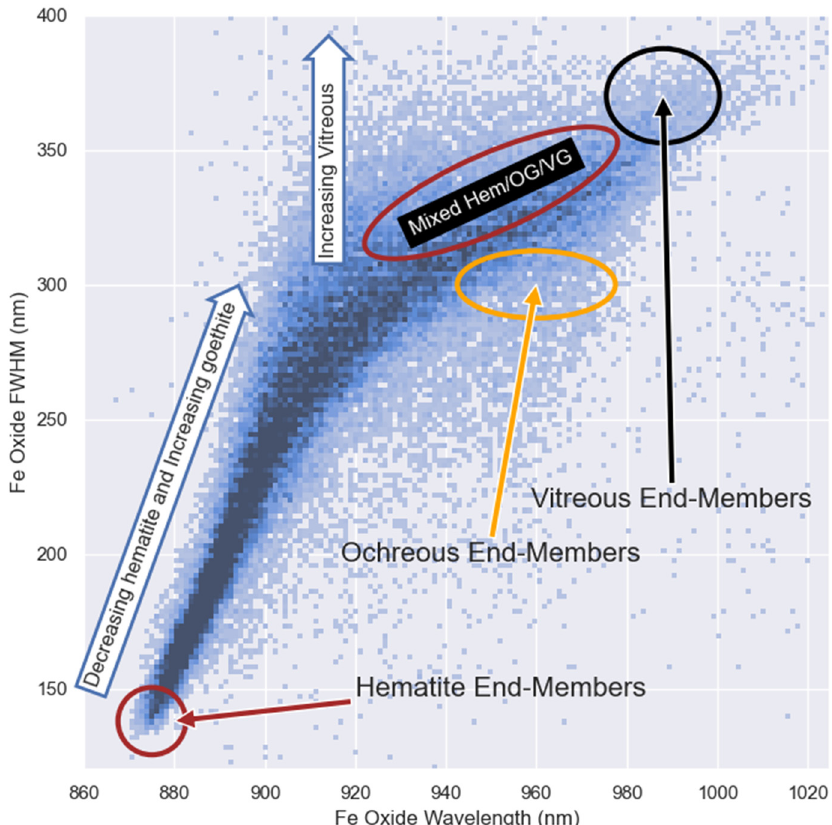
Figure 3. A density plot showing the general composition and placement of key locations within the iron boomerang. At each end, and, if present, spectral endmembers of hematite and vitreous goethite can be found. Traversing the iron boomerang from left to right and bottom to top the proportion of hematite to goethite decreases toward a more goethite dominated region at wavelengths greater than approximately 920 nm. As the continuum hull corrected Fe Oxide FWHM increases within the goethite dominated region a move from more ochreous goethite to greater proportions of vitreous goethite is observed with ochreous goethite endmembers generally located in the orange circled region. Away from the endmembers are mixtures of hematite, ochreous and vitreous